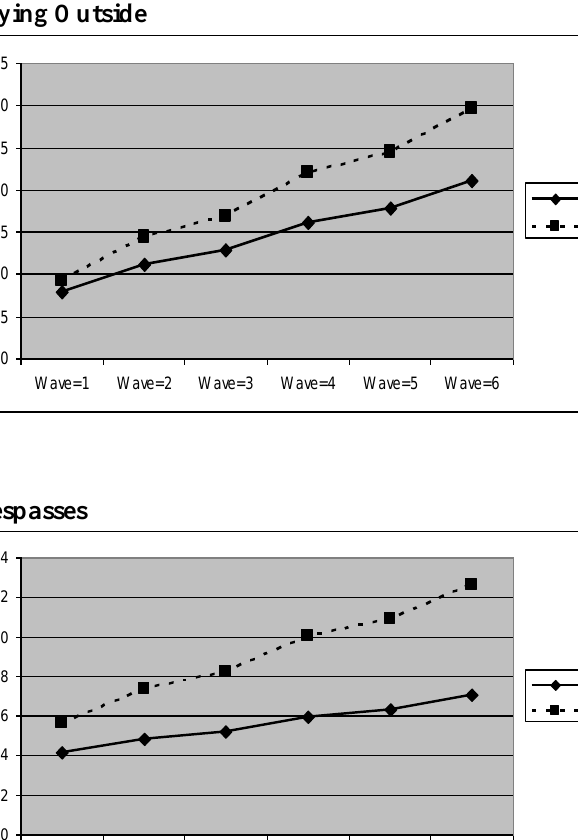
FIGURE 20 . Growth trajectories of the experimental group (Tier 1 participants who perceived the program as effective) and control group using the item score of trespasses as the outcome indicator.